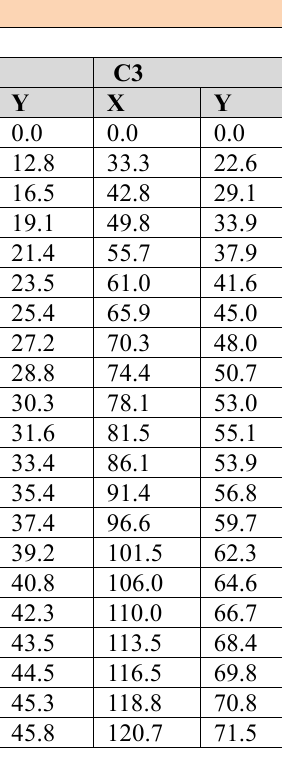
Table 8 Story displacement from Response spectrum analysis (Linear Dynamic analysis system,Analysis approach